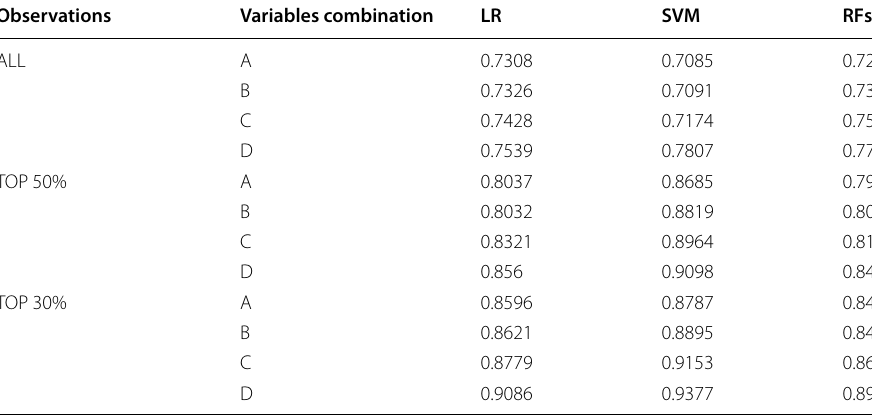
Table 7 Precision comparison of different predictive models